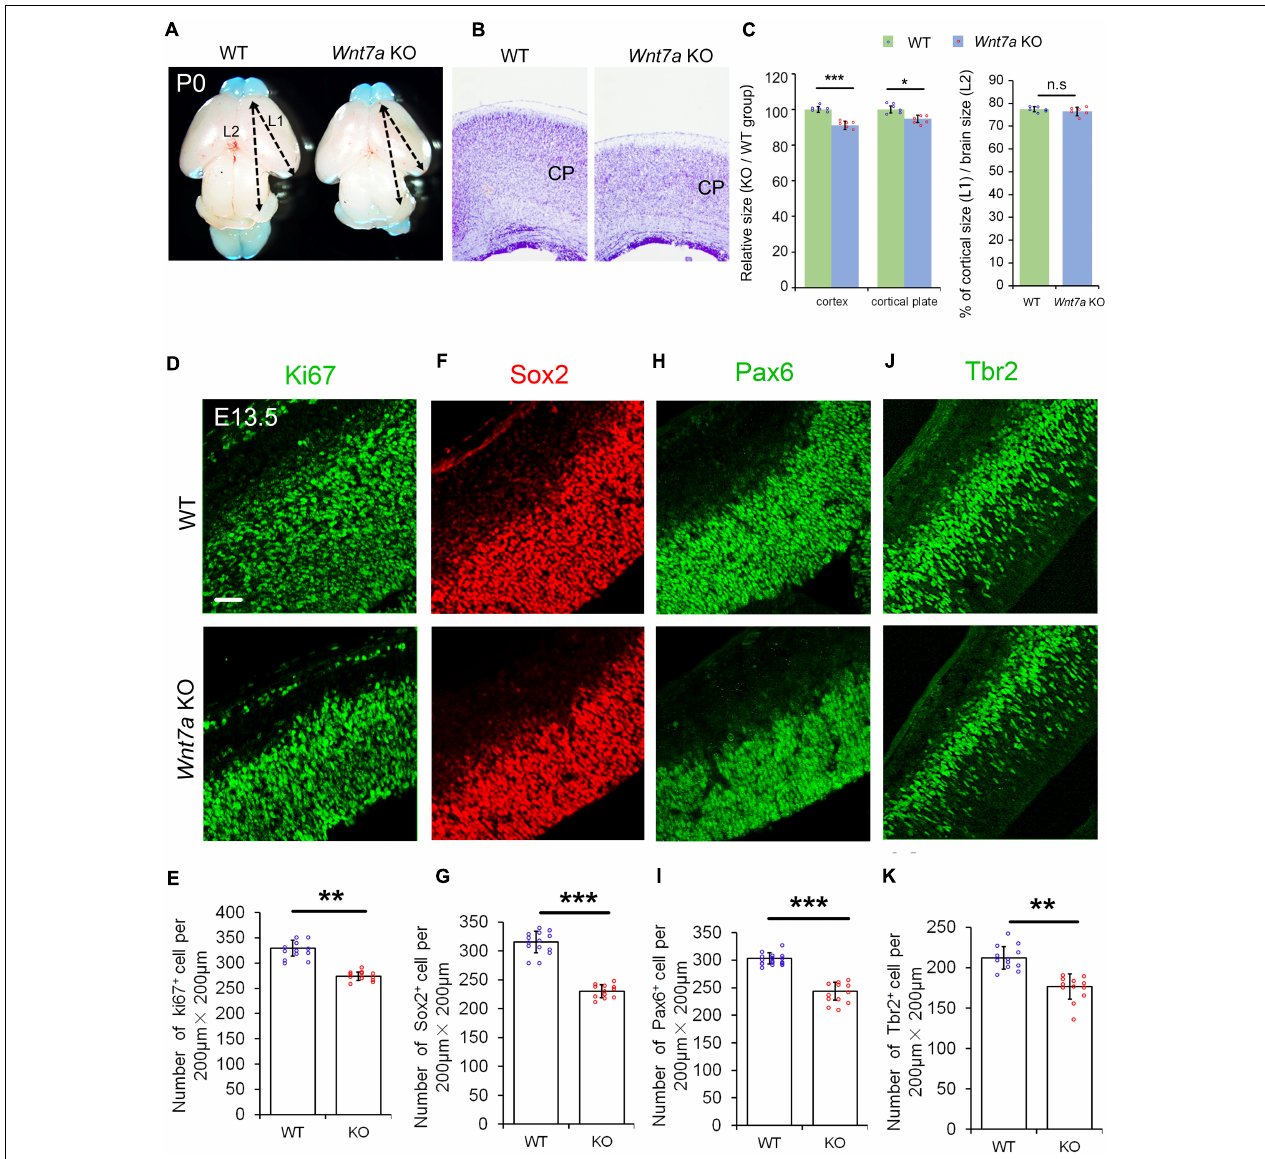
FIGURE 2 | Wnt7a positively regulates brain size and proliferation of NPs. (A) The cortex of P0 Wnt7a knockout (KO) mice was greatly reduced compared to wild type (WT) controls. The arrowheads show the most rostral and caudal regions in the cortex. “L1” represent the cortical length, and “L2” represent the brain length. (B) The cortical wall in P0 Wnt7a KO mice were thinner than that in WT mice, detected by Nissl staining. CP: cortical plate. (C) The relative thickness of the cortex and cortical plate in the KO was normalized from dividing the mean length of Wnt7a KO by that of the WT groups. Values of histogram represent mean ± SEM, and each dot represents a data point of the relative thickness in each section or length in the brain images. n = 3 brains, at least two sections from each brain. ∗ P < 0.05; ∗∗∗ P < 0.001; ns, non-significant; unpaired Student’s t -test. (D–K) The numbers of Pax6 + and Tbr2 + neural progenitors were greatly reduced in the E13.5 Wnt7a KO cortex. Values of histogram represent mean ± SEM, and each dot represents a data point of the counting number in each section (200 µ m bin). n = 3 brains, at least four sections from each brain. ∗∗ P < 0.01; ∗∗∗ P < 0.001; unpaired Student’s t -test). Scale bar: 50 µ m.